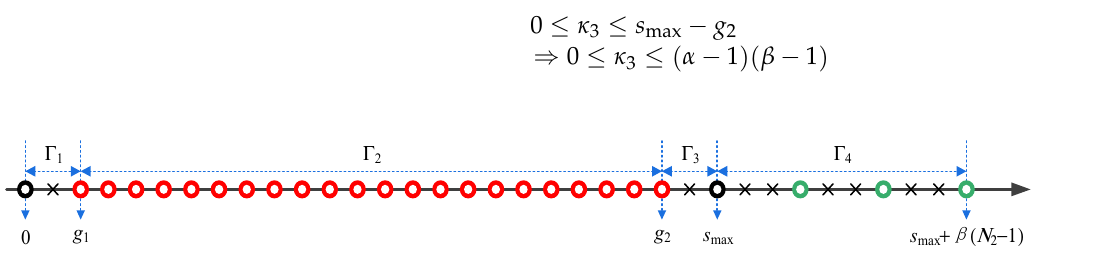
+  , where circles and crosses 